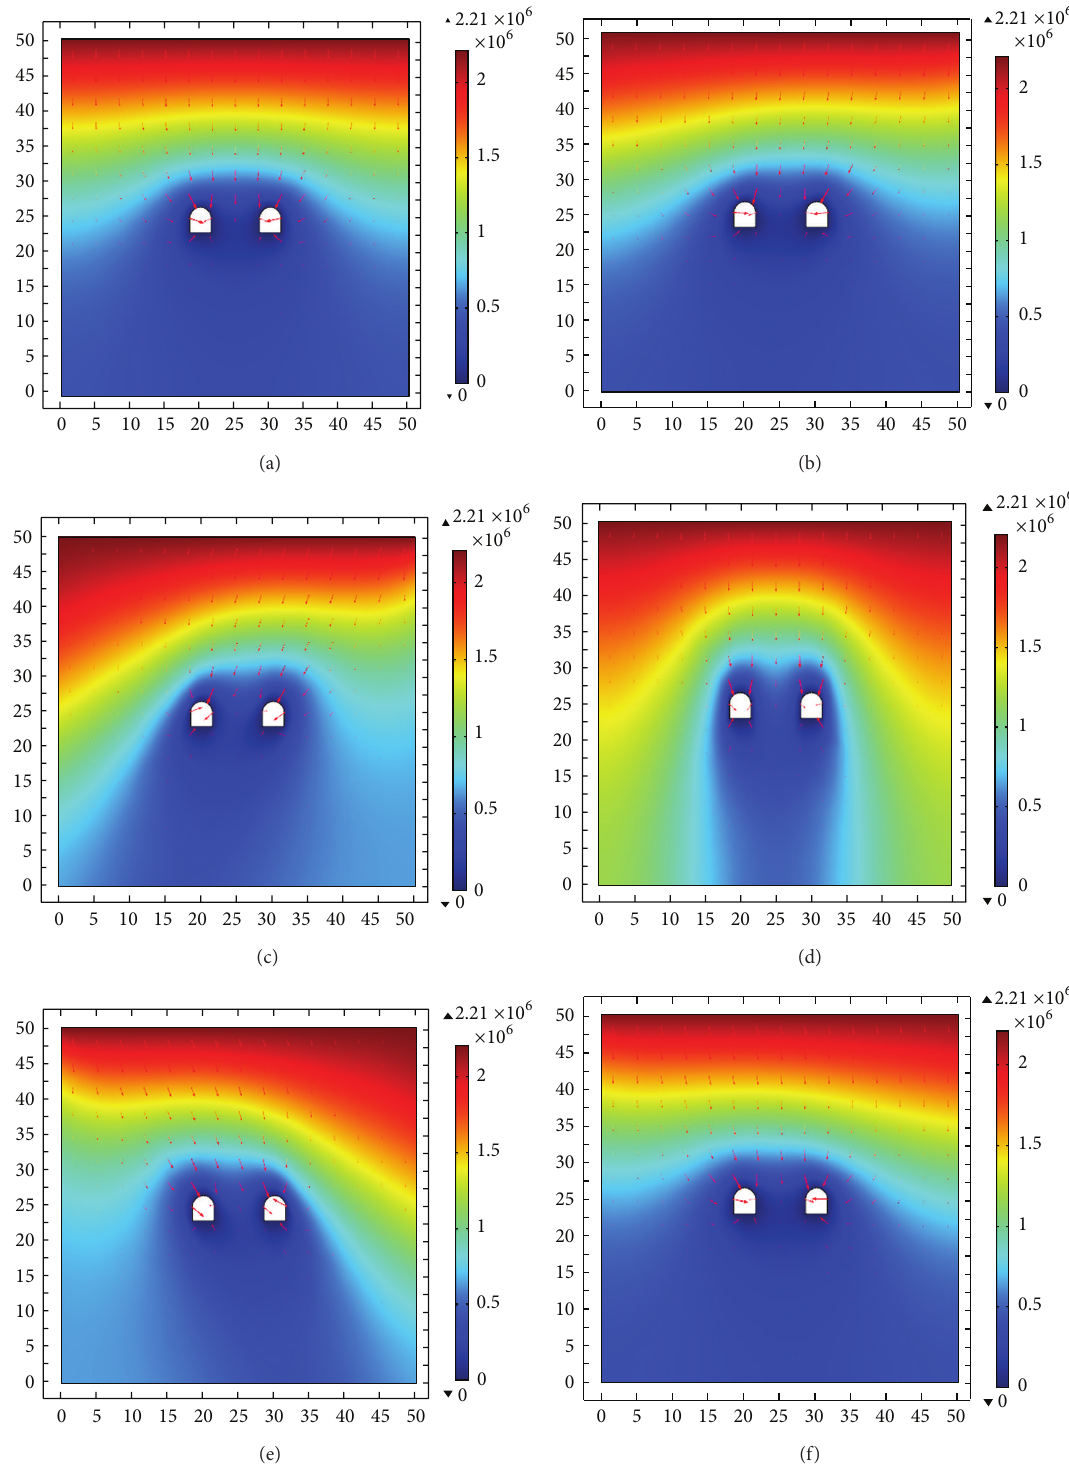
Figure 23: Contour of the fluid pressure and flow velocity vectors in different joint plane